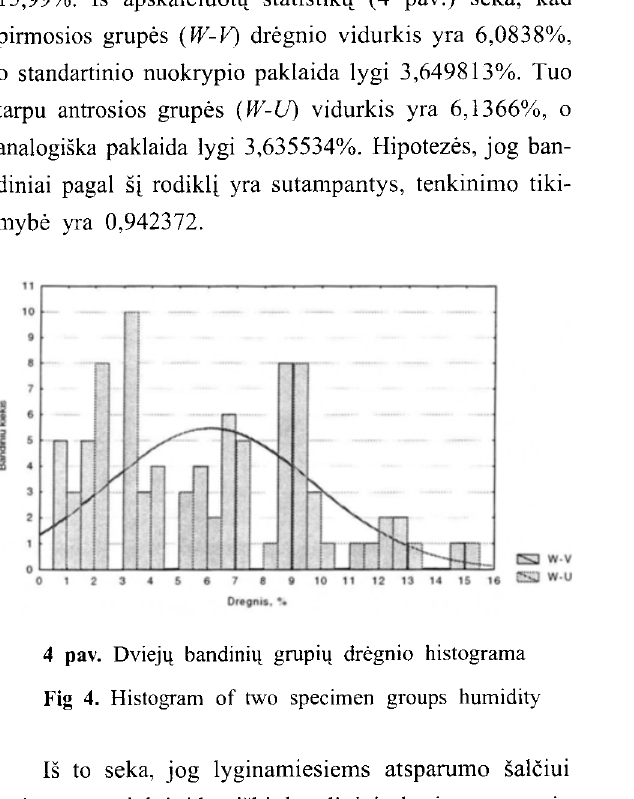
biitq visiskai nepatikima. Tai patvirtina mazas 1r ne ISJ 0-V r.s;) 0-U reiksmingas sios empiriskai gautos regresijos 1ygties ko reliacijos koeficientas (0,2161753) bei gana didele stan dartine ivercio paklaida, lygi 104,2040 cik1ams. Kadangi is esmes tarp rezultat4 ( 5 pav.) tiesinis rysys yra 1abai menkas, faktine prognozavimo pak1aida but4 1abai di